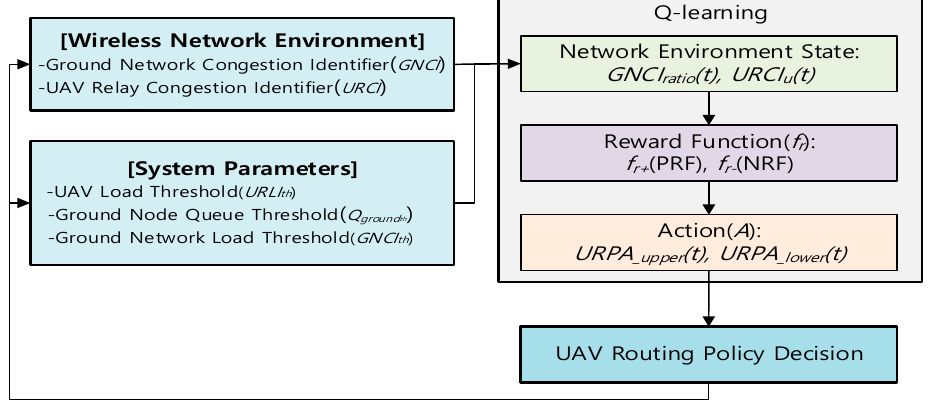
Figure 4. Q-learning design for Q-LBR.